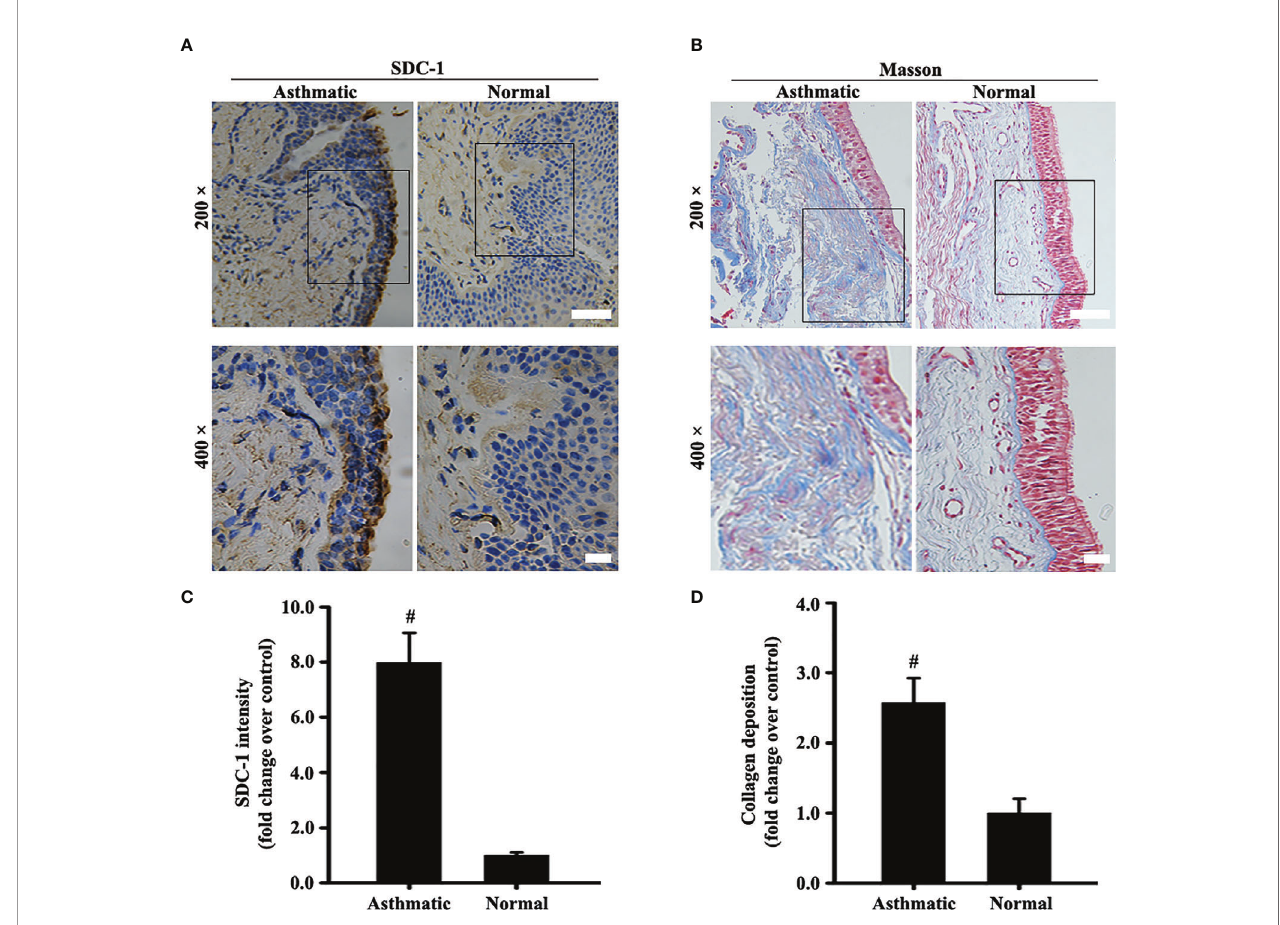
FIGURE 1 | SDC-1 levels in the asthmatic and normal human bronchial samples were evaluated by immunohistochemical staining (A) . Collagen deposition in the asthmatic and normal human bronchial samples was evaluated by Masson staining (B) . (C) SDC-1 intensity analysis of (A). (D) Collagen intensity analysis of (B) Data are shown as the means ± SD of three independent experiments. # p < 0.05 versus the control